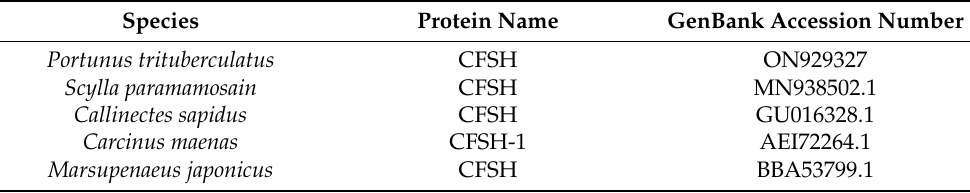
Table 2. List of species used in multiple sequence comparison phylogenetic